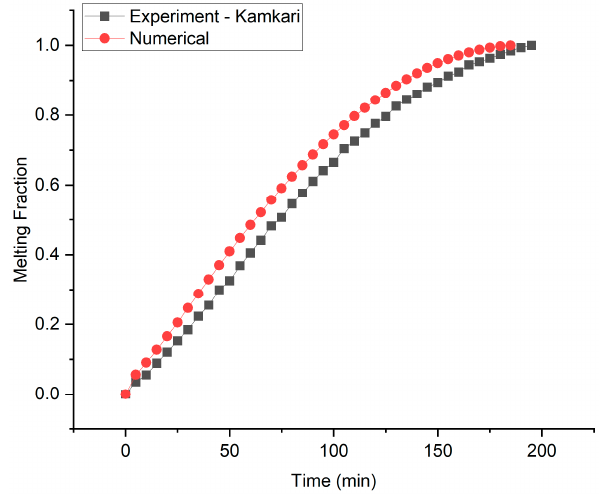
Figure 3. Numerical results comparison with experimental results reported by Kamkari.